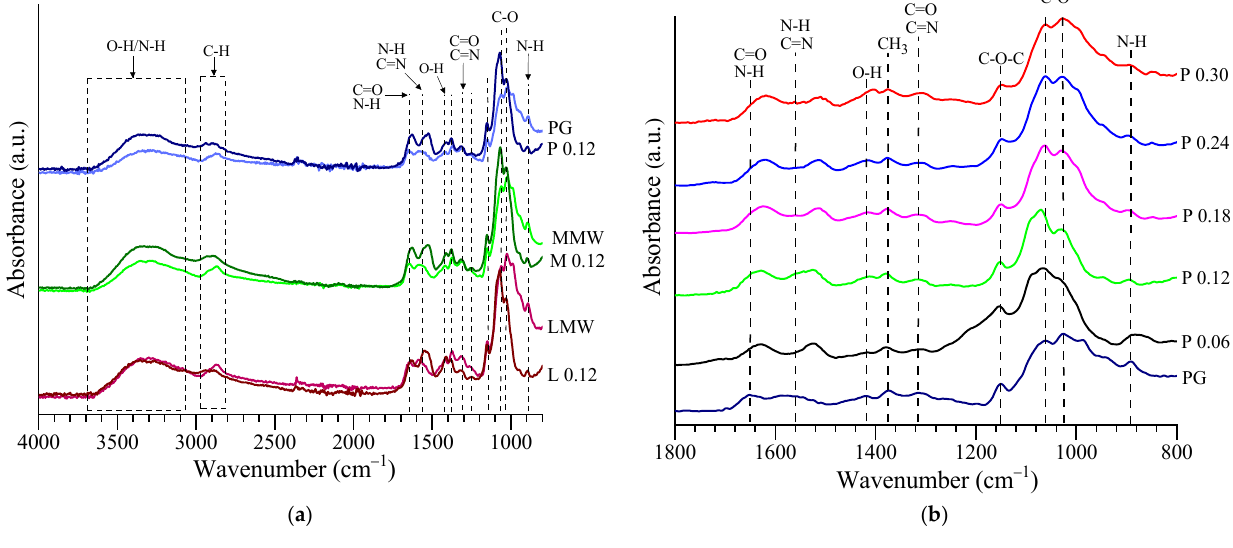
Figure 4. FTIR spectra of ( a ) used chitosan and lyophilized samples corresponding with a gold concentration of 0.12 mM and ( b ) all gold concentrations in the case of PG chitosan.